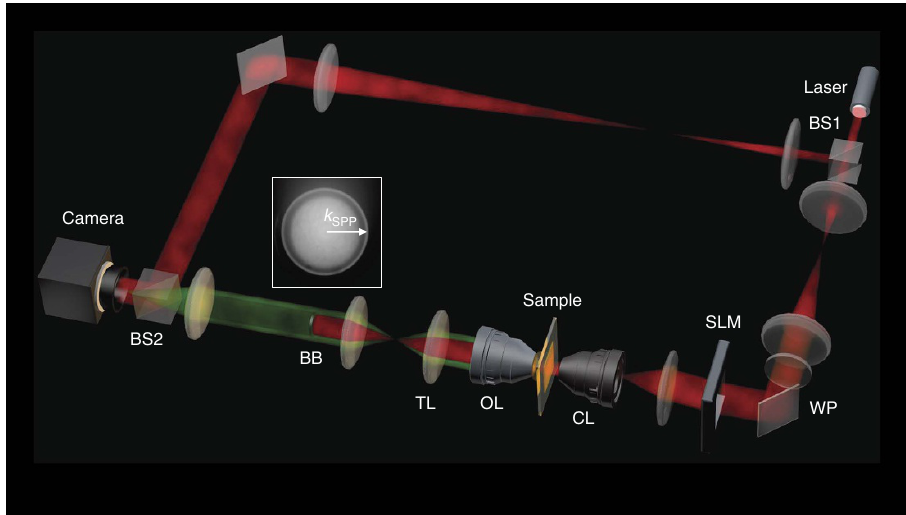
Figure 2 | Experimental setup for the measurement of a transfer matrix and the control of SPPs. An interferometric leakage radiation microscope equipped with a wavefront shaping device. An output beam from a helium–neon (He-Ne) laser was divided into sample and reference waves. SLM, reflection-mode spatial light modulator, but shown as transmission mode for simplicity. WP, quarter-wave plate; CL, condenser lens; OL, objective lens; TL, tube lens; BB, a circular beam block plate removing the far-field components of transmitted waves; BS1 and 2, beam splitters. The image shown above BB is the intensity image taken in front of BB. The bright sharp ring, whose radius corresponds to k SPP , is the intensity of SPPs at the Fourier